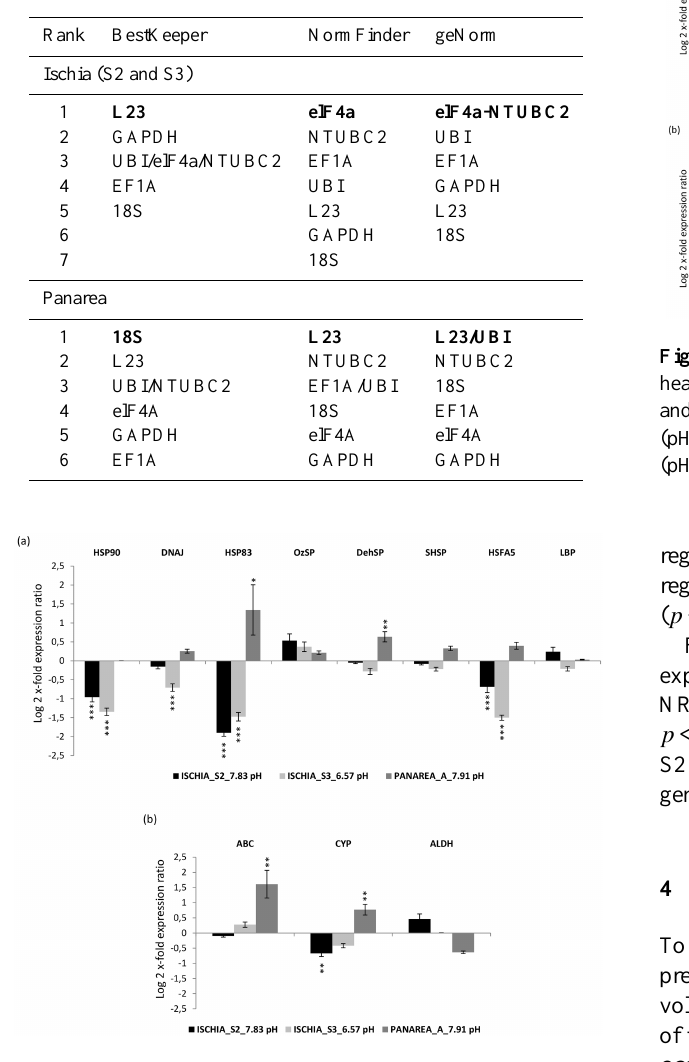
Table 2. Best reference genes as given by BestKeeper, NormFinder and geNorm analyses, for each sampling location (Ischia and Panarea). Genes are ranked from the most stable (in bold) to the least stable.